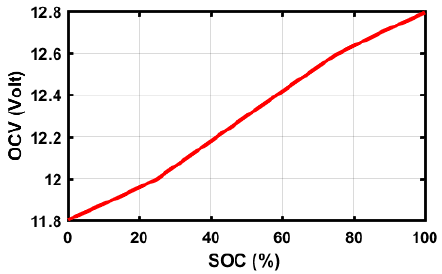
Figure 13. OCV vs SOC for the employed 12 V lead-acid battery. Figure 13. OCV vs. SOC for the employed 12 V lead-acid